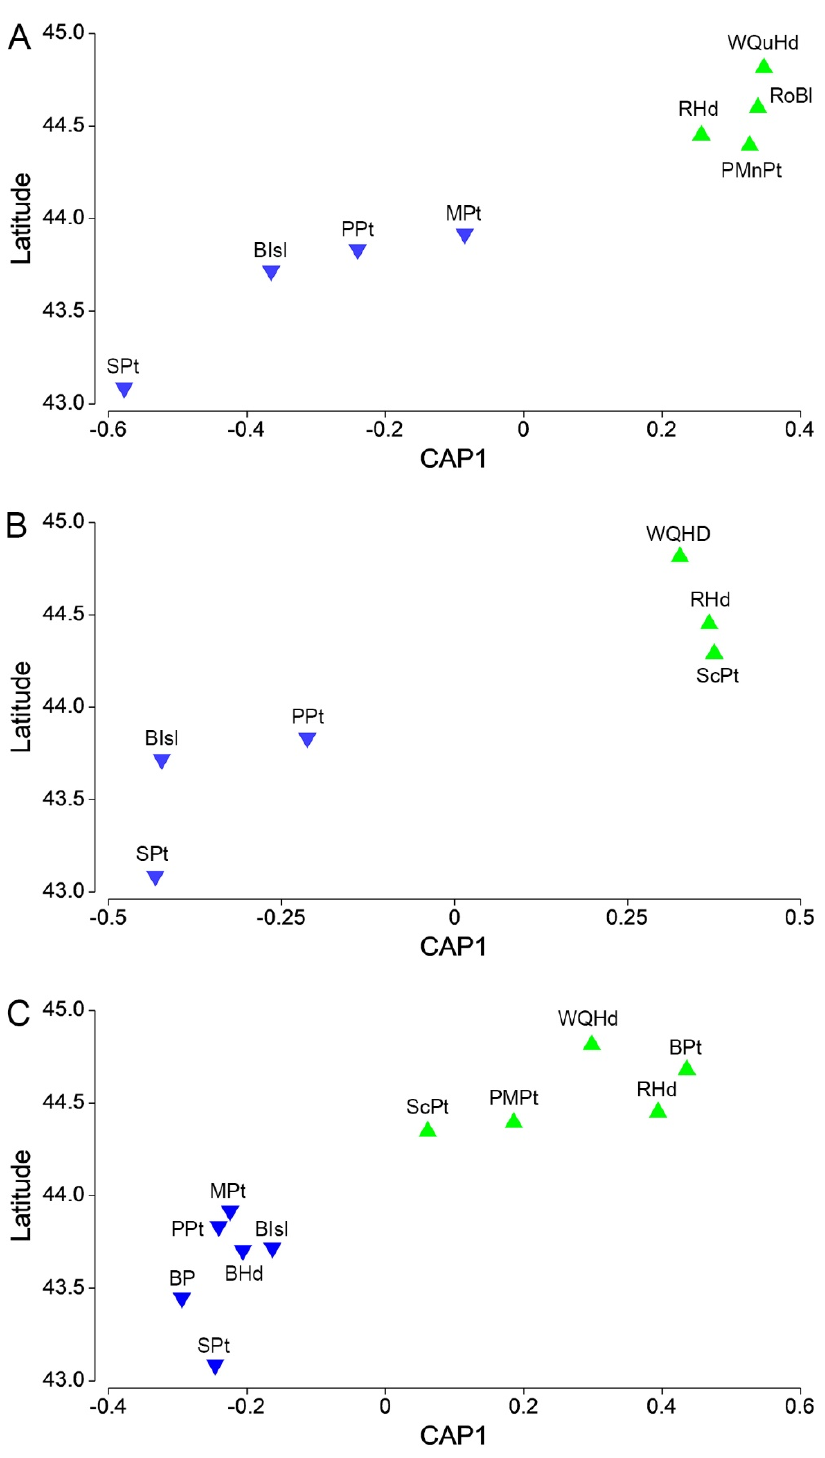
Figure 5. Canonical ordinations of rocky intertidal species assemblage similarity with latitude. ( A ) 2004; ( B ) 2007; ( C ) 2012. Symbology: Blue triangles, southern GoM region; green triangles, northern GoM region. Abbreviations: BIsl, Bailey Island; BHd, Bald Head; BP, Biddeford Pool; BPt, Black Point; MPt, Marshall Point; PPt, Pemaquid Point; ScPt, Schoodic Point; SPt, Sea Point; PMPt, Petit Manan Point; RHd, Red Head; RoBl, Roque Bluffs; WQHd, West Quoddy Head.